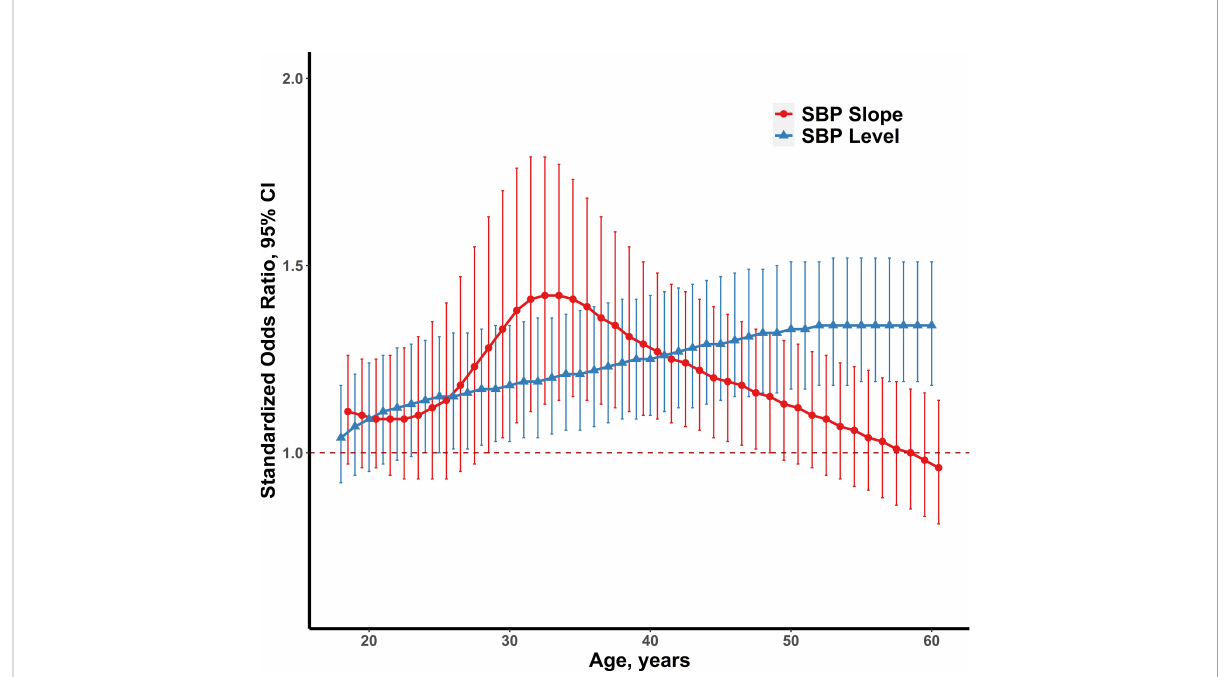
FIGURE 2 The standardized ORs and 95% CIs of model-estimated SBP levels and level-adjusted SBP slopes for adult diabetes (n=248), adjusting for gender, smoking, alcohol drinking, physical activity, energy intake, antihypertensive drugs use and baseline SBP (left), and model-estimated levels and linear slopes of BMI (right). SBP, systolic blood pressure; BMI, body mass index; OR, odds ratio; CI, con fi dence interval.